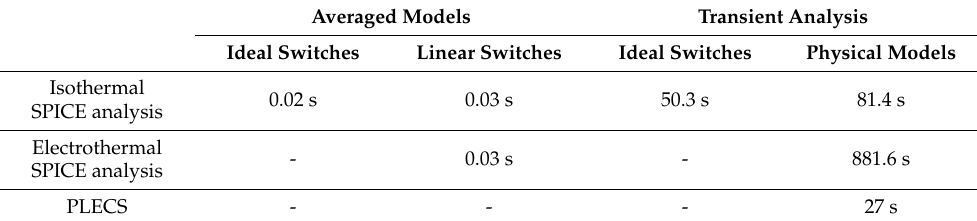
Table 4. Duration time of the computations performed using selected